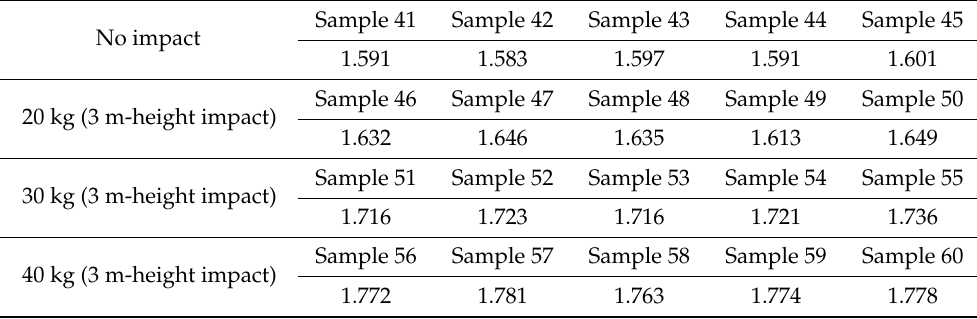
Table 5. The fractal dimensions of concrete samples after burning (foot of the